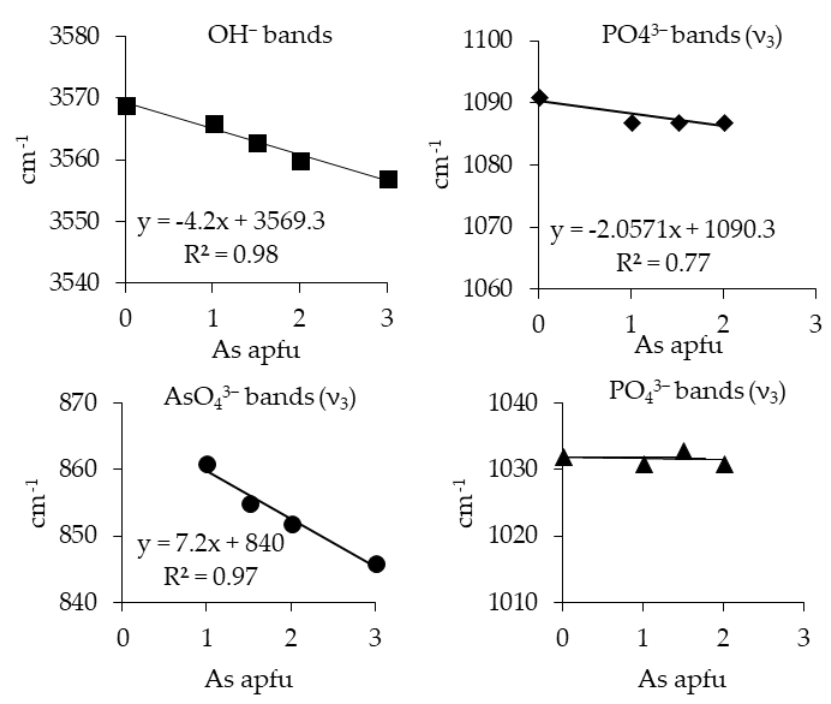
Figure 7. Linear variations in the position of the FTIR bands in the JBM–HAP solid solution series.